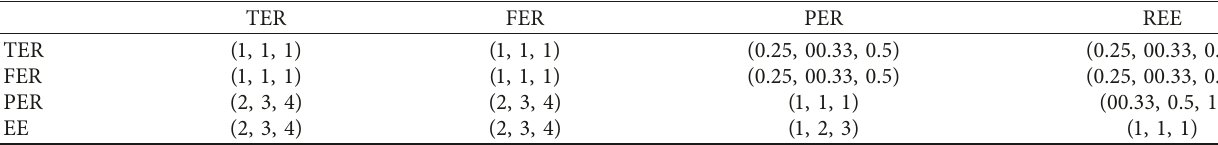
Table 9: Pairwise comparison matrix for criteria.